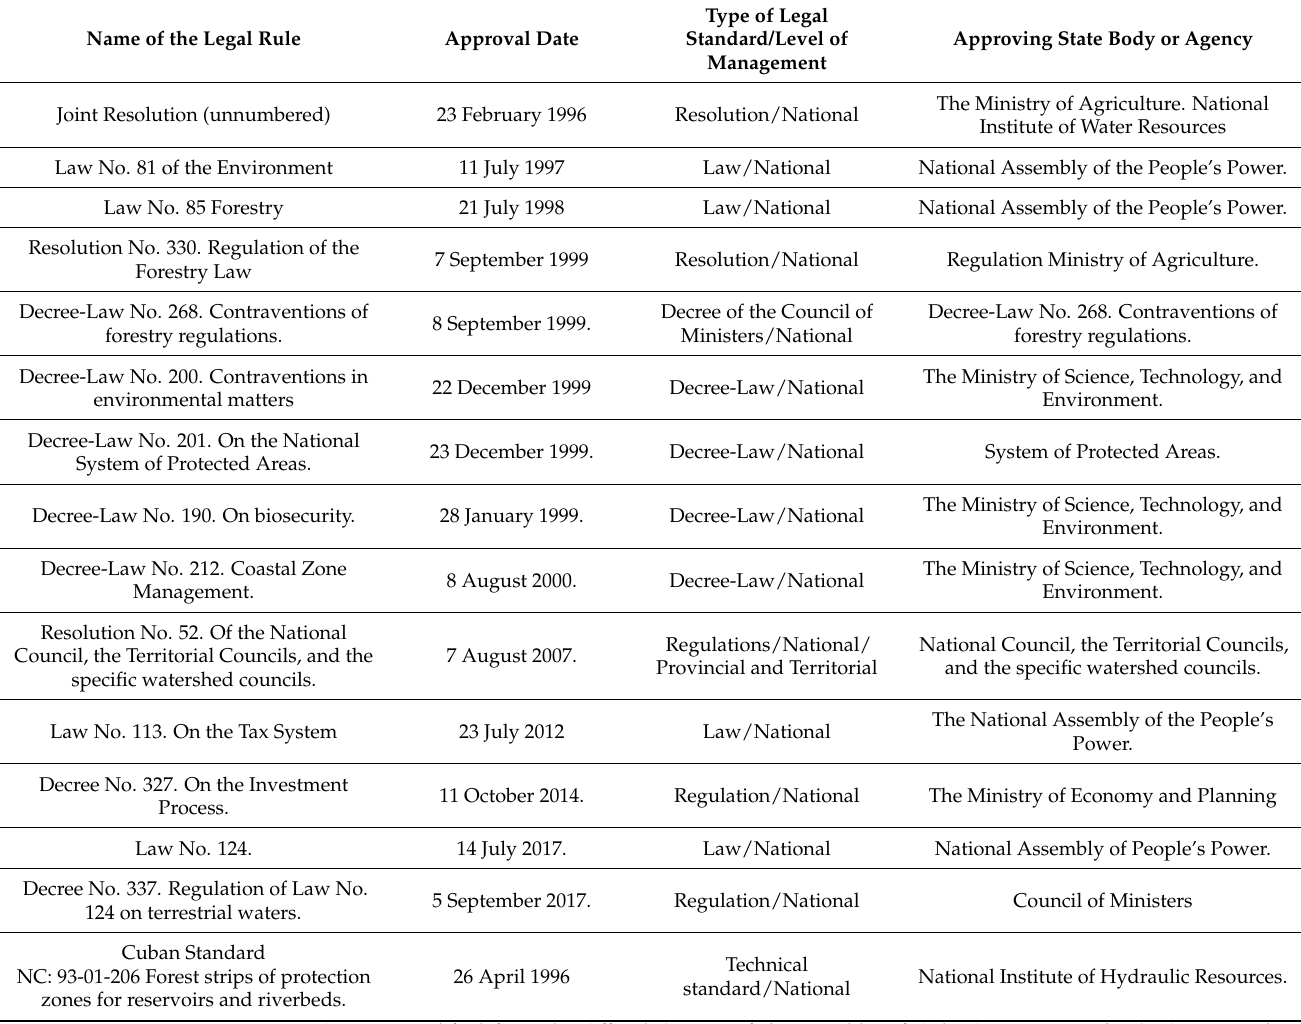
Table 2. Legal norms identified on forest cover in watersheds in